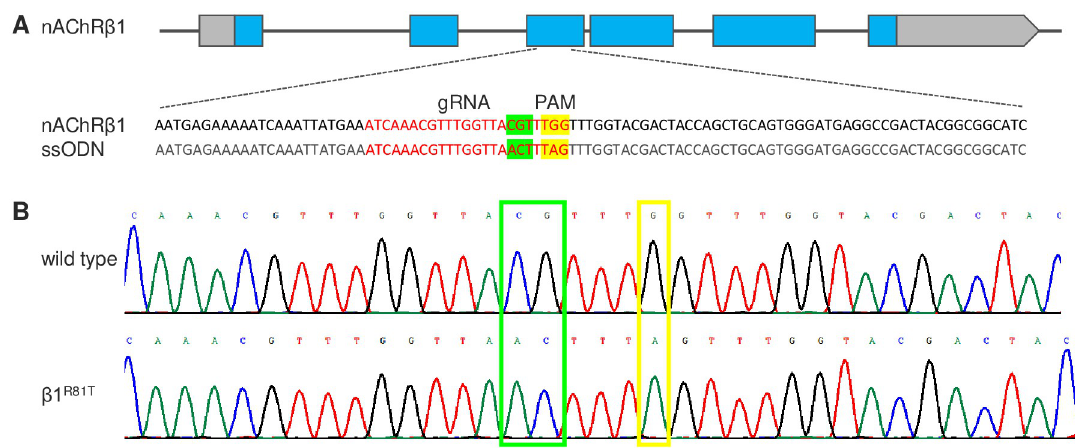
Fig 1. Generation of the nAChR β 1 R81T mutant by CRISPR/Cas9 genome editing. (A) Schematic of the nAChR β 1 locus and the sequence of the donor construct. The boxes represent exons, and the coding regions are shown in blue. The gRNA sequence is indicated in red, and the codon for amino acid substitution (CGT to ACT) is highlighted in green. One synonymous mutation (G to A) is also introduced in the PAM region (in yellow) to prevent recleavage from Cas9 after successful integration. (B) Sequence comparison between wild-type flies and flies with point mutations. The nucleotides replaced are highlighted in green and yellow boxes.